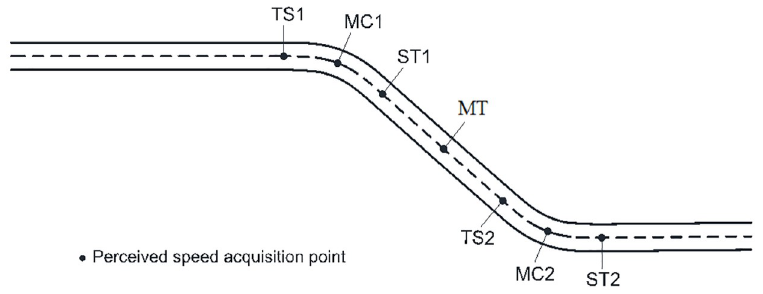
Fig 7. Reverse curve perceived speed acquisition point and horizontal